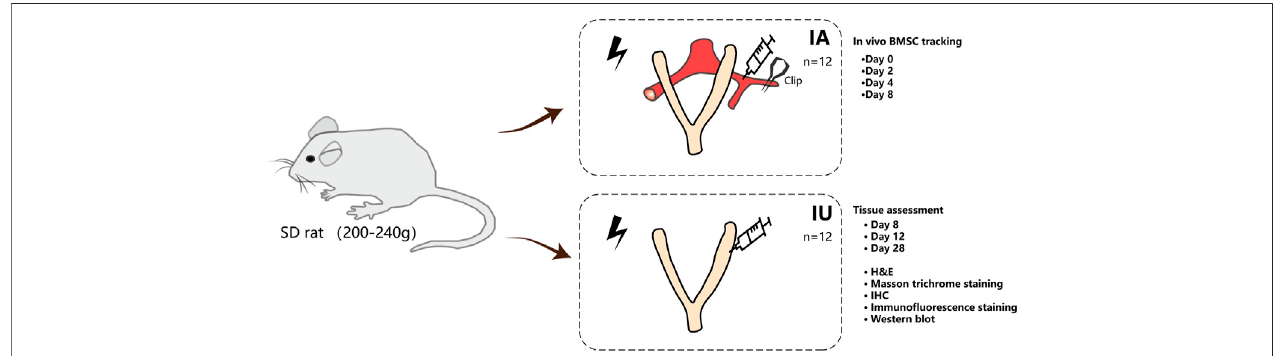
FIGURE 1 | Study design and experimental schematic. BMSCs were isolated from the femora of rats and were labeled with EGFP and luciferase. BMSCs were injected into thin endometrium models either through the damaged horns directly or through the ipsilateral iliac artery when the external iliac artery was clamped by nontraumatic artery clips for less than 15 min. The rats were imaged by in vivo imaging systems immediately after closing the abdomen to con fi rm ideal infusion. At 2, 4, and 8 days posttreatment,BMSC recruitment wasevaluatedbyIVIS. Theuteriwereexcised 8,12,and 28 days aftertherapyand subjectedtoHandE,Masson ’ s trichrome, IHC staining, and Western blotting. For each group and each time point of examination, a size of three animals was